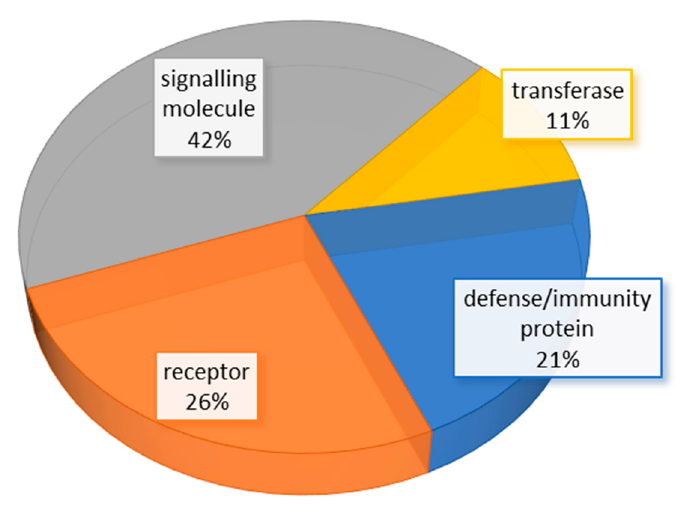
Figure 2. Classification of identified proteins based on the Panther classification system.